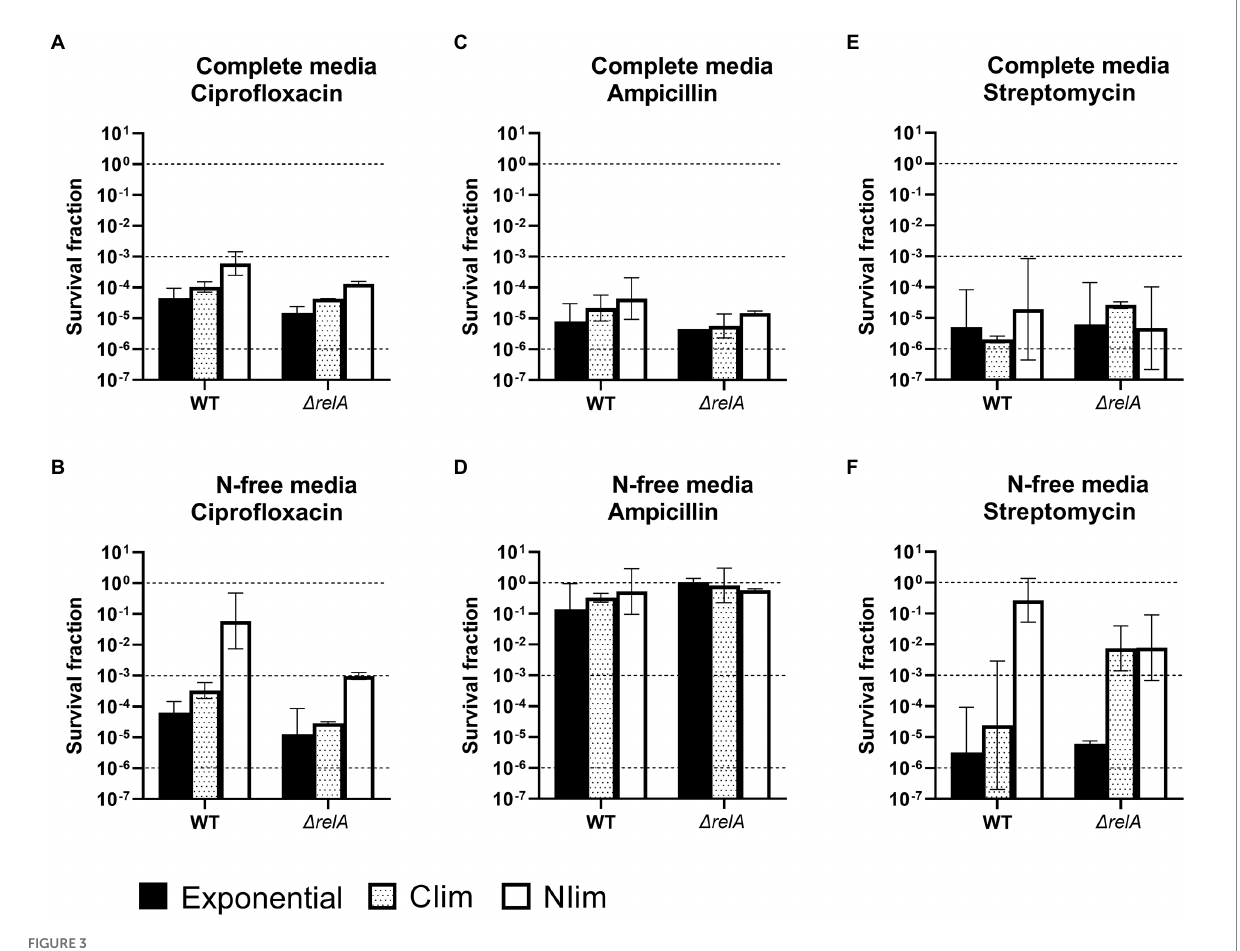
FIGURE 3 Survival of E. coli WT and Δ relA cells. E. coli WT and Δ relA cells were pregrown to three physiological states (exponential phase, carbon or nitrogen- limited stationary phase; Clim or Nlim) in benchtop bioreactors, before centrifugation and resuspension into two stress media with (A) and (B) 5 μ g/ml ciprofloxacin, (C) and (D) 100 μ g/ml ampicillin or (E) and (F) 25 μ g/ml streptomycin. Viable cell counts were assayed at 0 and 5 h after treatment, and the surviving fractions at 5 h were calculated. Geometric mean and geometric standard deviation from 2 to 4 experiments are plotted, with a dotted line at 10 0 , 10 − 3 , and 10 − 6 to for visualization. WT results from Figure 2 are included to ease comparison and interpretation. N-free, HAS medium lacking nitrogen; Exp, exponential phase; Clim, carbon-limited stationary phase; Nlim, nitrogen-limited stationary